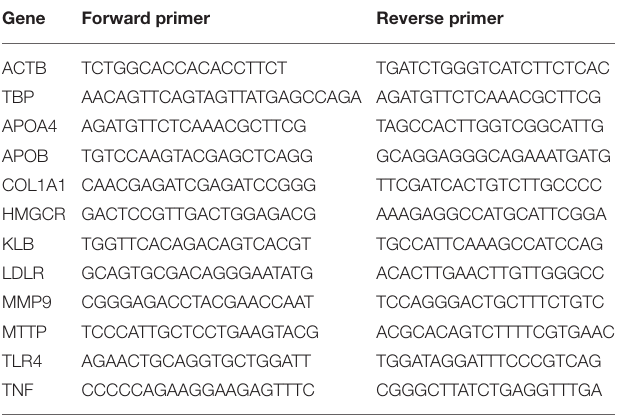
TABLE 2 | Subset of primer sequences for qPCR